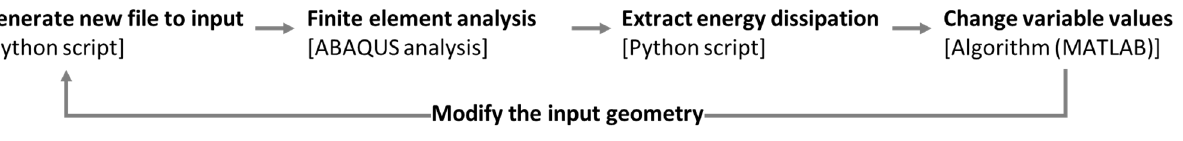
Figure 3. Flowchart of the optimization.